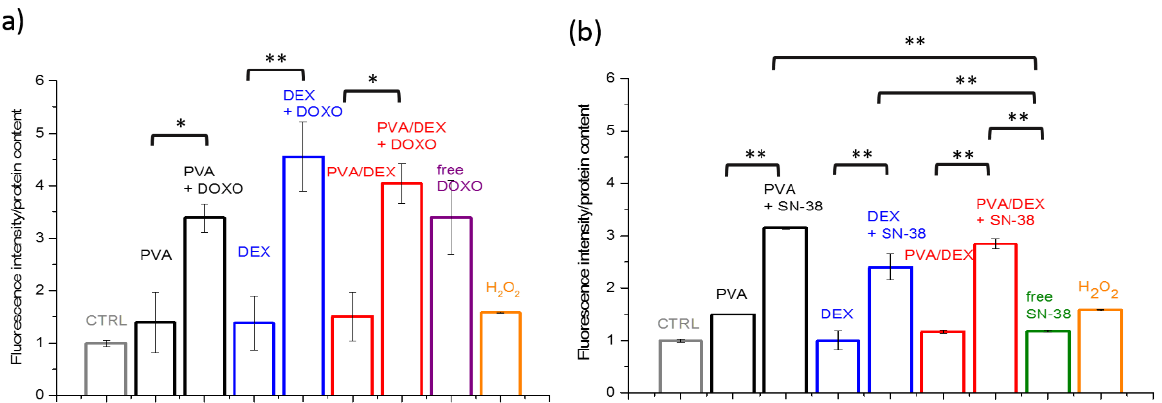
Figure 5. DCF assay (reported as the fluorescence intensity/protein content, normalized to the control sample) performed with MCF-7 cells incubated with the NPs coated with the three types of surfactants and loaded with either ( a ) DOXO (for 72 h) or ( b ) SN-38 (for 120 h). The cells were administered with a drug concentration equal to 1 µ M and 100 nM in the case of DOXO and SN-38, respectively. H 2 O 2 treatment (1 mM) for 1 h was used as a positive control. (*) and (**) indicate statistical significance with p < 0.05 and 0.01, respectively.